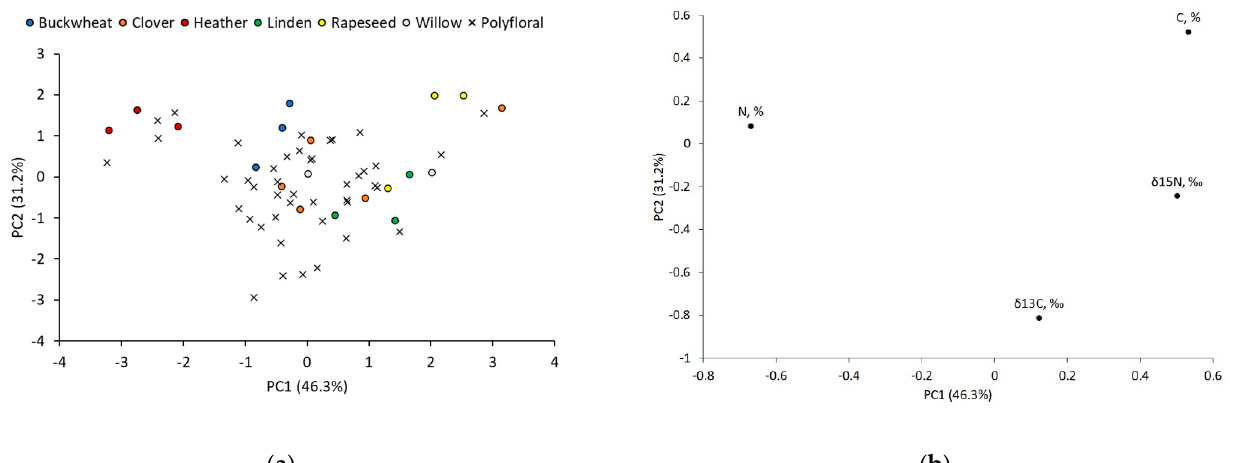
Figure 3. PCA of monofloral buckwheat, clover, heather, linden, rapeseed, willow, and polyfloral honey samples: ( a ) score plot between PC1 and PC2, and ( b ) loading plot of variables obtained by IRMS ( δ 13 C, δ 15 N, total C and N in honey proteins).